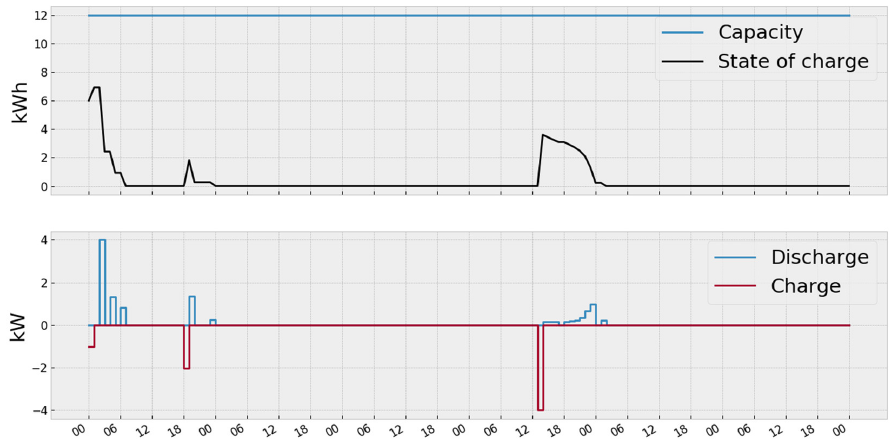
Figure 7. Dynamics of the charge and discharge of batteries for Case 4 for optimal policies, π ∗ obtained using PPO algorithm for the one-week testing